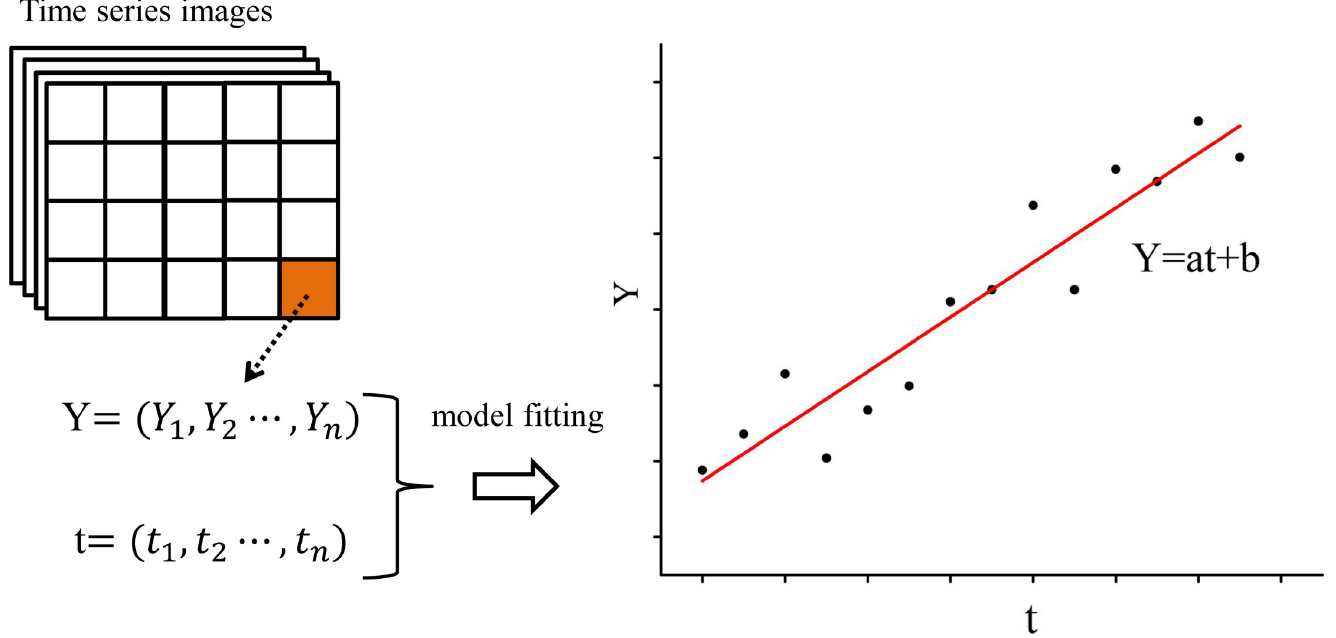
Fig 3. Illustration of linear model fitting of time series